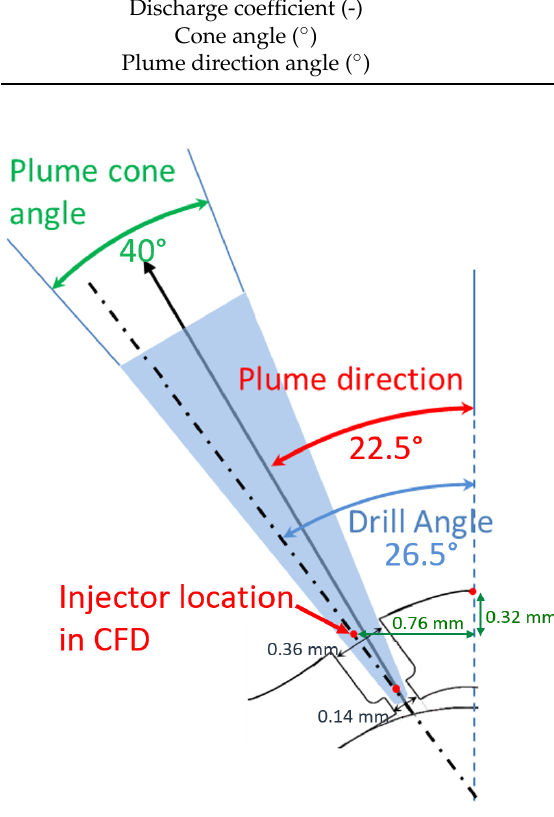
Figure 1. Schematic of the Bosch HDEV 1.2 injector with the plume cone angle as well as the plume direction angle, used as inputs in the LES. Angles and distances are not to